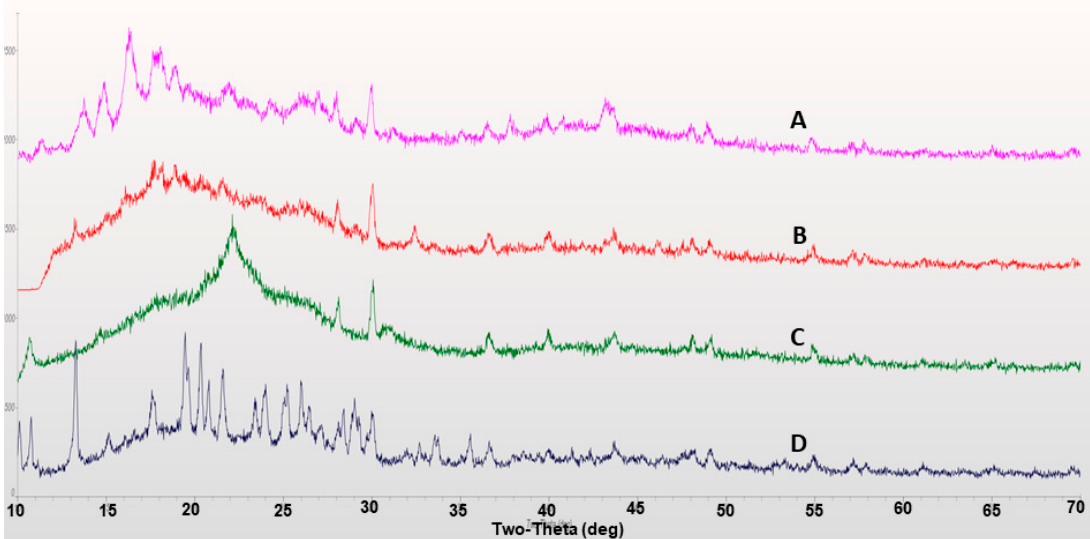
Figure 4. X-ray di ff raction (XRD) di ff ractograms of ( A ) cholesterol, ( B ) clotrimazole loaded ufosomes, Figure 4. X-ray diffraction (XRD) diffractograms of ( A ) cholesterol, ( B ) clotrimazole loaded ufosomes, ( C ) sodium oleate, and ( D ) ( C ) sodium oleate, and ( D ) clotrimazole.